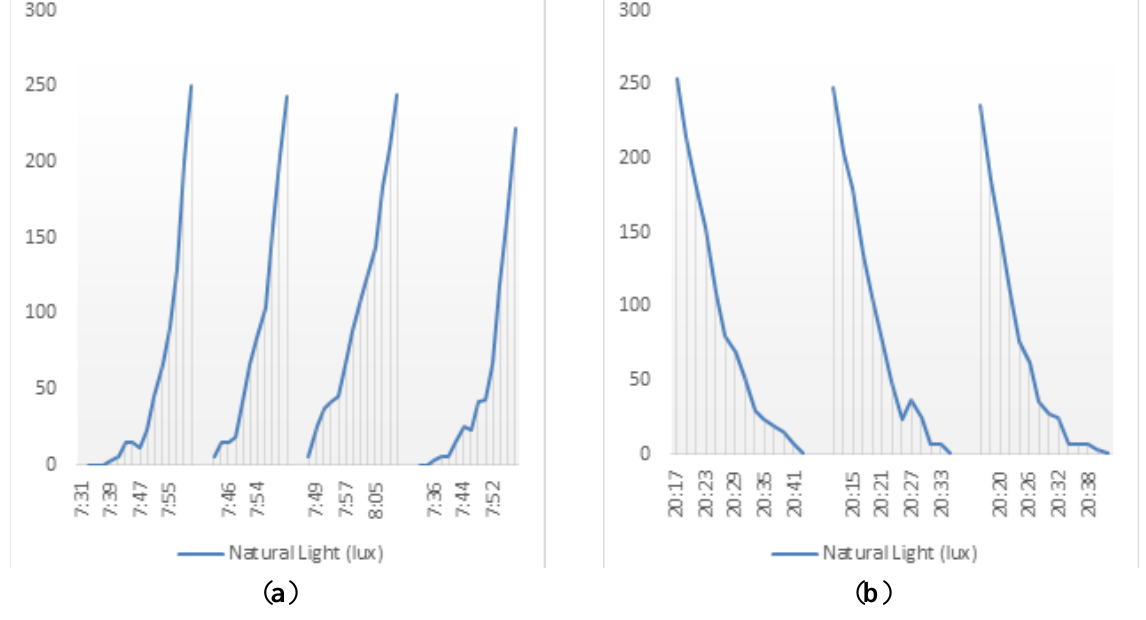
Figure 2. Natural light level during the sunrise ( a ); and during the sunset ( b ) in Madrid.